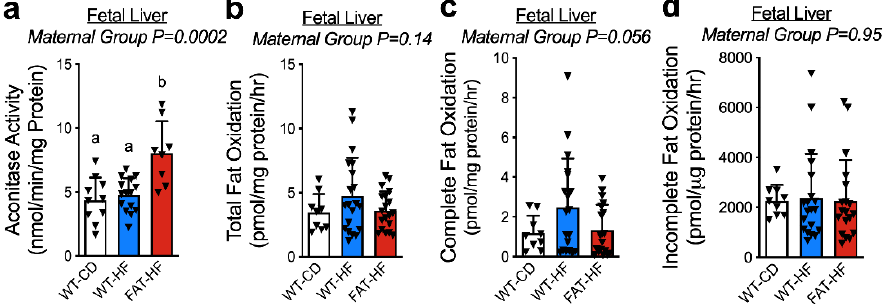
Figure 2. Maternal fat-1 transgene alters aconitase activity and complete fatty acid oxidation in fetal liver. Aconitase activity ( a ) and total fatty acid oxidation ( b ) were measured in fetal liver samples from WT dams fed a control diet (WT-CD), or o ff spring of WT or fat-1 hemizygous dams fed a high-fat diet (WT-HF and FAT-HF, respectively) throughout pregnancy, with sample collection at day E18.5. Total fatty acid oxidation is the sum of complete fatty acid oxidation to CO 2 ( c ) and partially oxidized fatty acids ( d ). All data are presented as mean ± SD. Di ff erent letters above bars denote statistically significant di ff erences between those bars at p < 0.05 significance level.